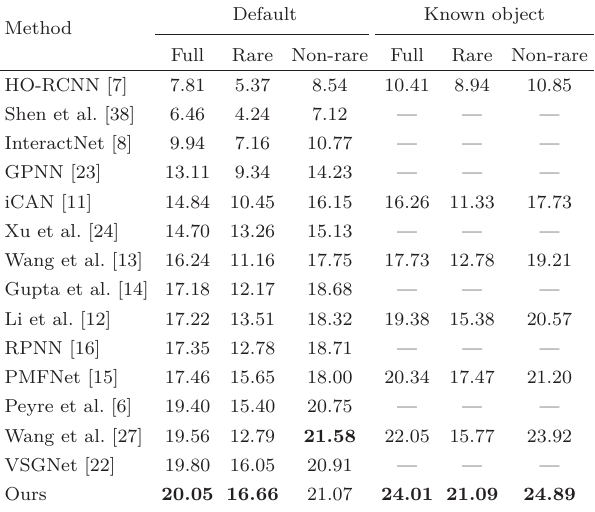
Table 2 Comparison with state-of-the-art methods on the HICO- DET [7] test set.